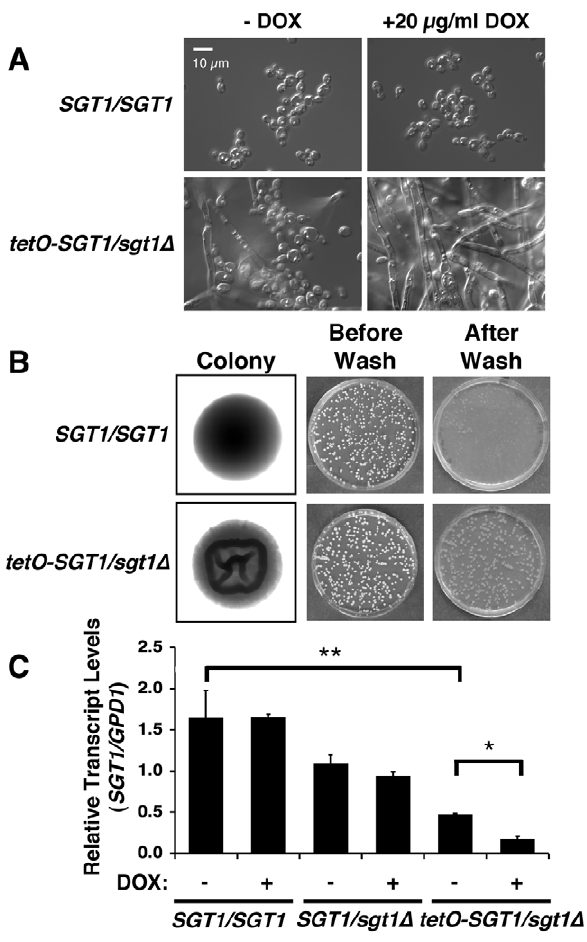
Figure 1. Genetic depletion of Sgt1 induces filamentation, wrinkly colony morphology and invasive growth. (A) Genetic depletion of Sgt1 induces filamentation. Sgt1 levels were reduced by growth overnight in 20 m g/ml doxycycline, followed by subculture in fresh medium with 20 m g/ml doxycycline. (B) Genetic depletion of Sgt1 in the tetO-SGT1/sgt1 D strain leads to wrinkly colony morphology and invasive growth. Cells were plated on YPD agar and grown at 37 u C for 3 days. Colonies were washed from the plates with H 2 O. (C) The tetO- SGT1/sgt1 D strain has lower SGT1 transcript levels compared to wild type in the absence of doxycycline (** indicates P , 0.01, ANOVA), and SGT1 levels are completely depleted upon treatment with doxycycline (* indicates P , 0.05, ANOVA). Wild type, SGT1/sgt11 D , or tetO-SGT1/ sgt1 D cells grown overnight in 20 m g/ml doxycycline, followed by subculture in fresh medium with 20 m g/ml doxycycline and grown until mid-log phase, as indicated. SGT1 transcript levels were normalized to GPD1 . Data are means 6 standard deviations for triplicate